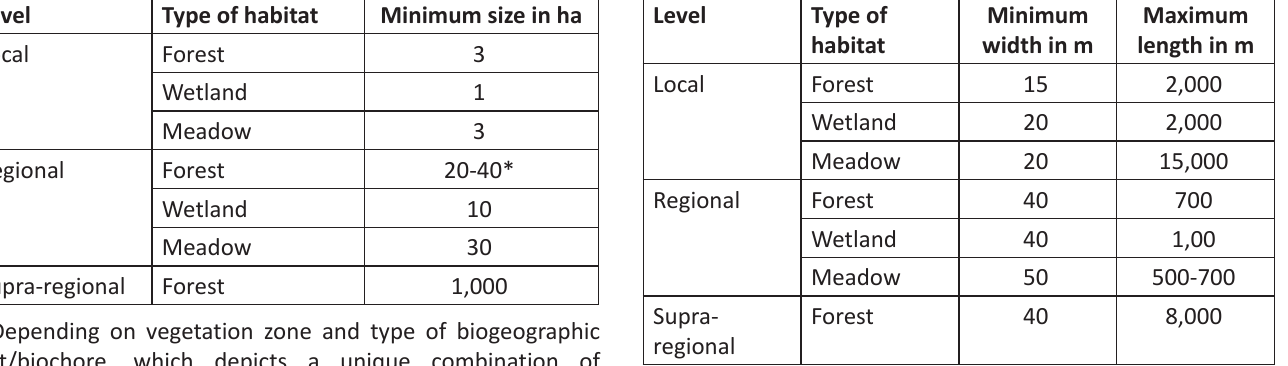
Landscape Online – supported by the International Association for Landscape Ecology and its community